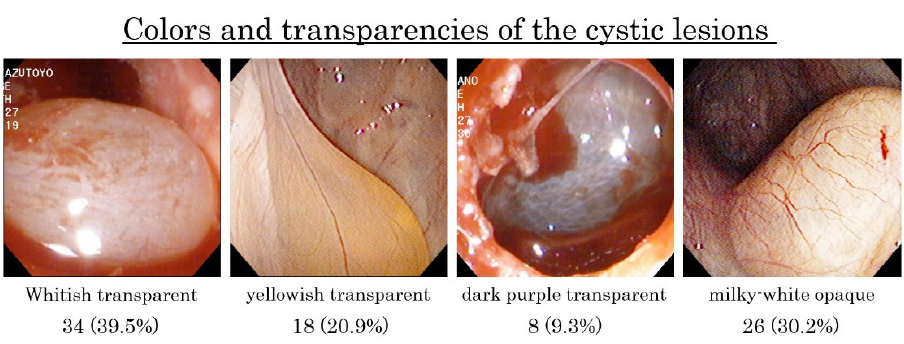
Figure 10. The colors and transparencies of the cystic lesions were classified into four types by the visual and endoscopic examinations. The 60 cystic lesions (69.8%) were transparent and 26 (30.2%) were opaque.